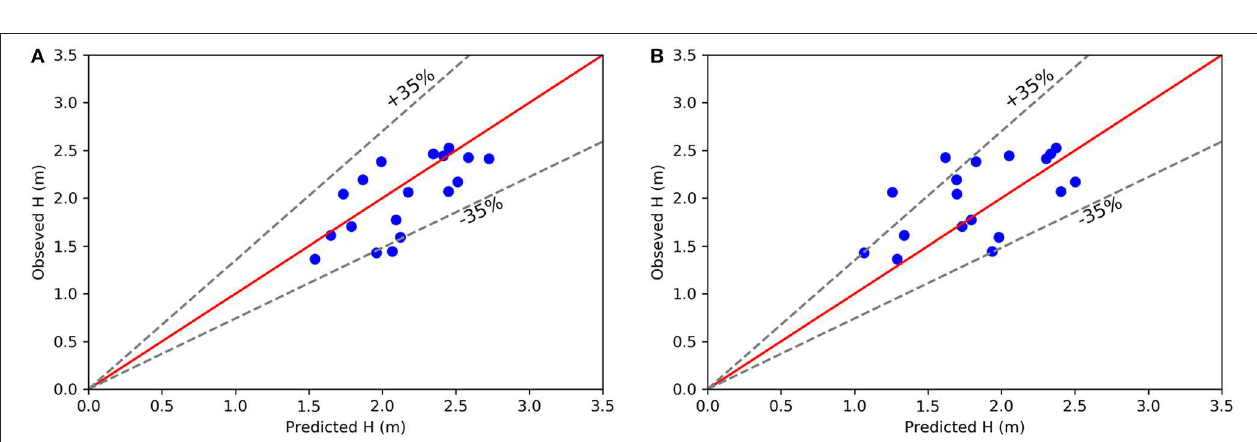
FIGURE 3 | Maximum flame height per experiment as a function of heat release rate plotted against two-fifths power law and Sun et al. power law for chaparral fuels burned in fall season. Maximum heat flux estimated using: (A) Method 1, ˙ Q max obtained from ˙ m max [ ˙ Q max , Method 1 ∼ ˙ m ( t ˙ m ˙ Q ˙ m t H max , Method 2 ∼ ˙ m ( t flame height , max ) ( n = 18). max (cid:1) (cid:0)